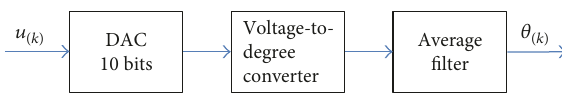
Figure 12: Data read sensor program for the elbow.